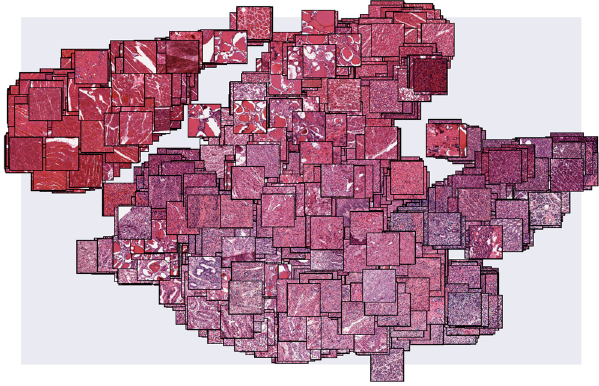
Fig. 1 The embeddings of GTEx histological images. The image feature representation estimated by ImageCCA for each of the GTEx histological images may be visualized by embedding the images based on their feature values into two dimensions using t-SNE 56 . We plot each histological image in this two-dimensional space. Images with similar morphological features are closer together, with skeletal muscle tissues forming a noticeably distinct cluster from the remaining tissue types in the upper left